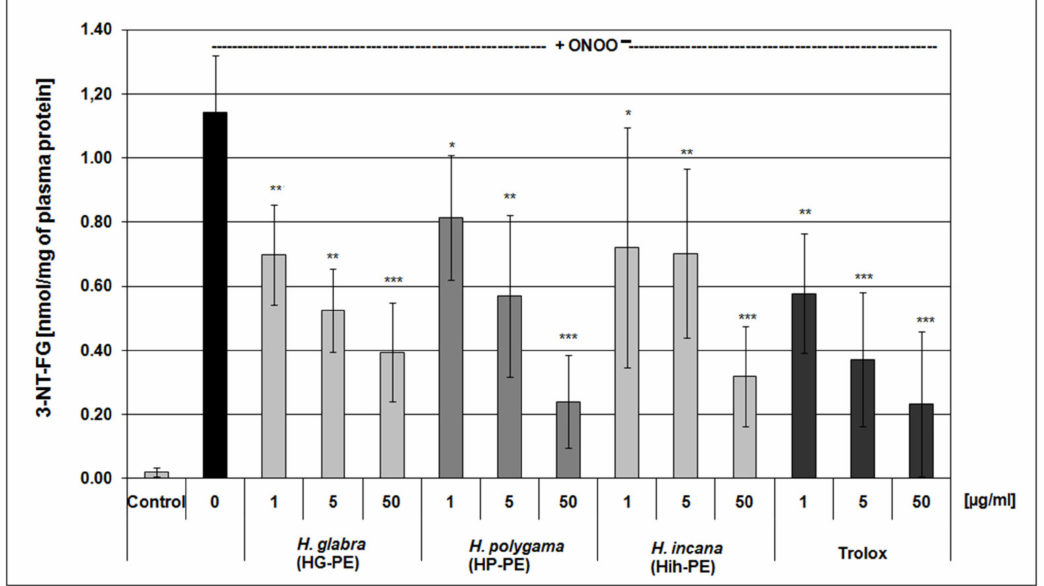
Figure 3. Protective effects of the examined Herniaria glabra (HG-PE), H. polygama (HP-PE) and H. incana herb (HIh-PE) purified extracts on the ONOO − -induced formation of 3-nitrotyrosine in blood plasma proteins. Human plasma was exposed to 100 µ M ONOO − in the presence or absence of the tested extracts or a reference compound (Trolox); * p < 0.05, ** p < 0.01, *** p < 0.001; n =